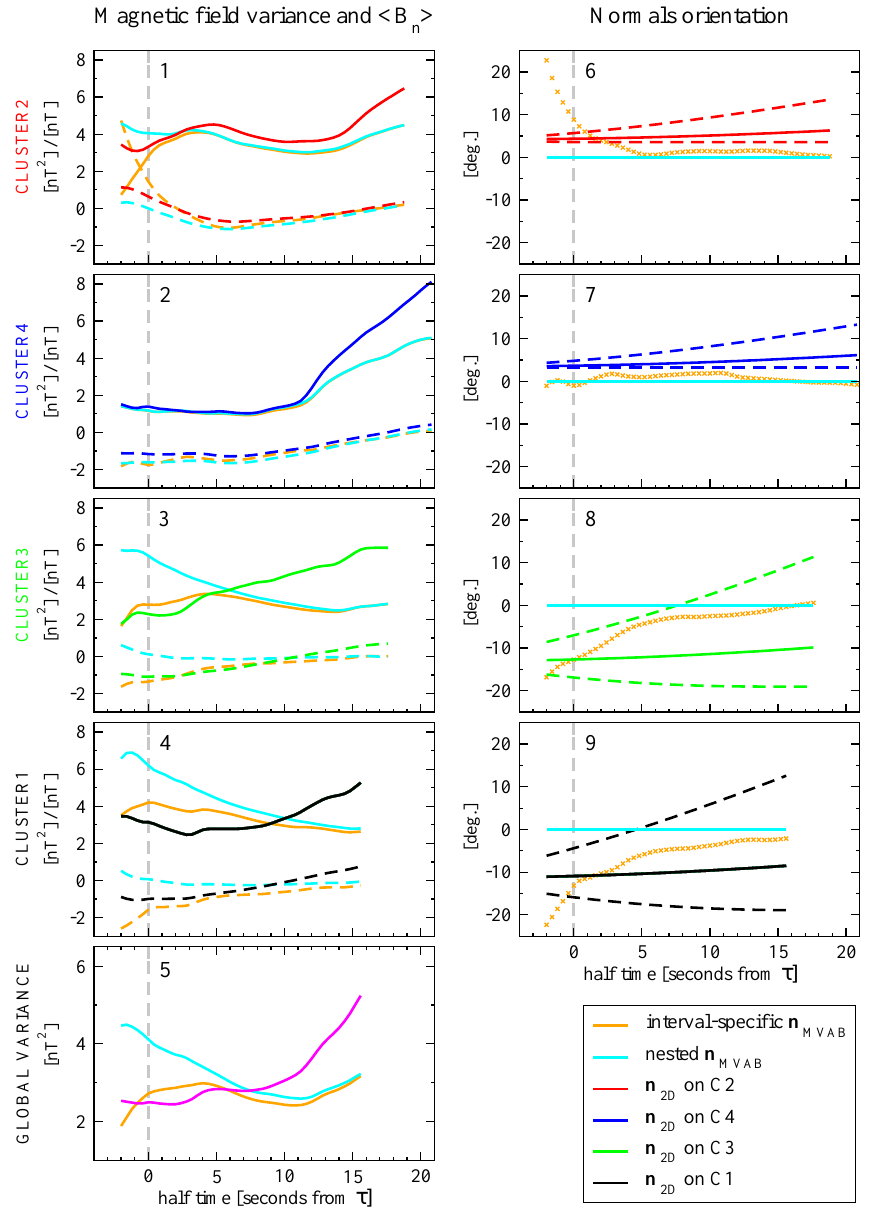
Fig. B1. Comparison between the C2 OpTA A solution and the results from planar MVAB technique. Left column: The first four panels present the magnetic field variance (solid lines) and average normal magnetic field component (dashed lines) corresponding to MP intervals centred on T ci . The intervals half-width, in seconds from τ i , is shown on the abscissa. The plotted quantities were computed based on three sets of normals, as explained in the text. The bottom panel presents the global normal magnetic field variances. Right column: The relative orientation of the three sets of normals as a function of interval half-width. In all the panels, the vertical dashed line corresponds to the central intervals [ T ci − τ i ,T ci + τ i ] , used in the timing analysis. More explanations are given in the